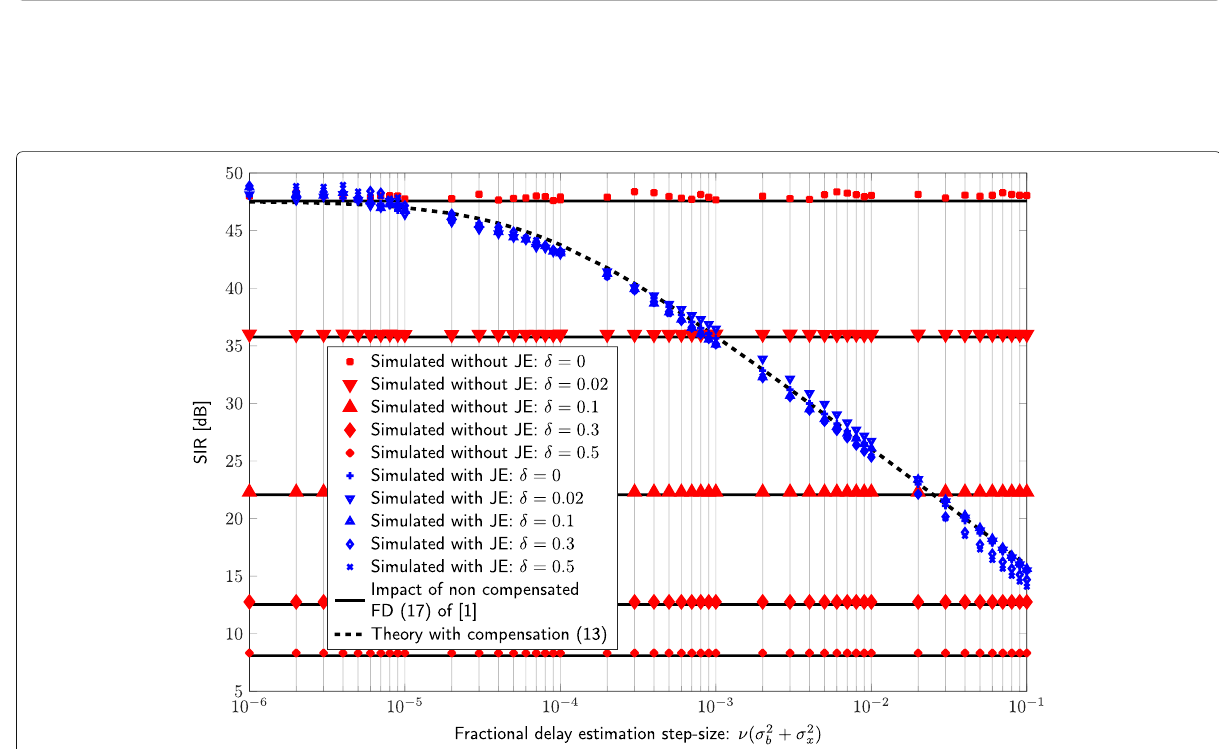
Fig. 8 JE asymptotic performance. Asymptotic performance of the compensation algorithm for several values of the fractional delay step-size and for different values of fractional delays for a fixed fractional delay step-size μ = 10 −